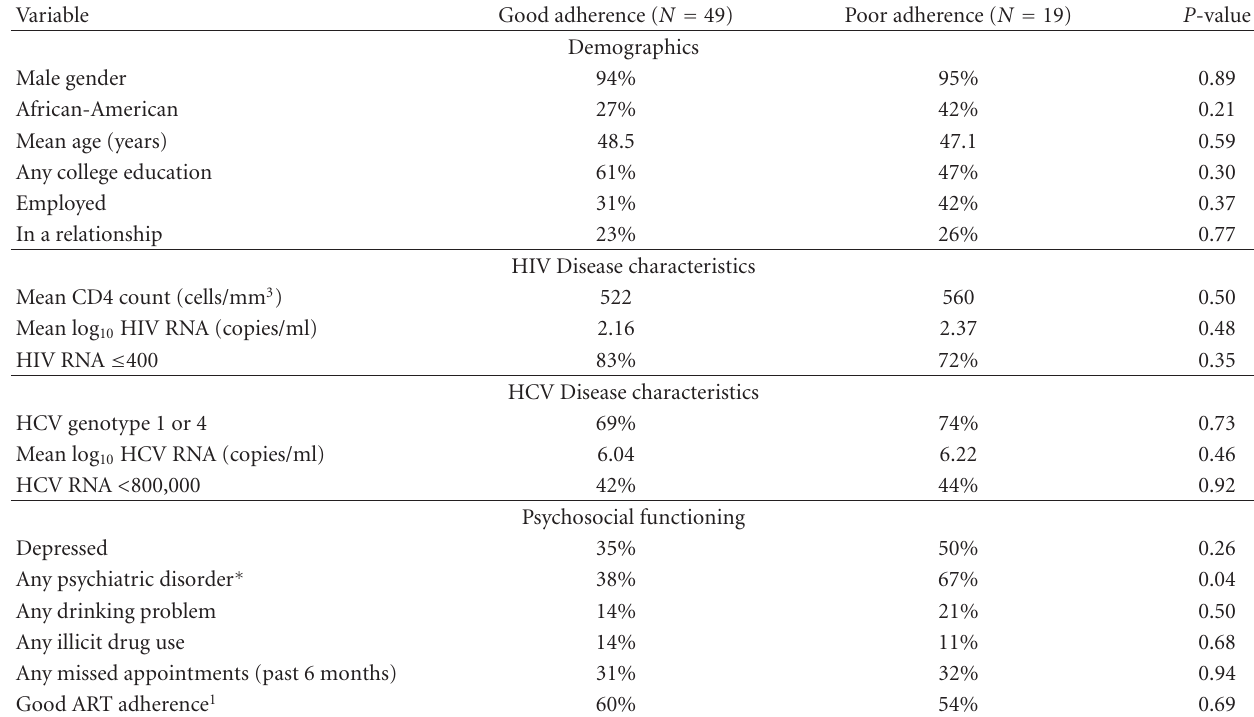
Table 1: Patient characteristics and HCV treatment adherence.